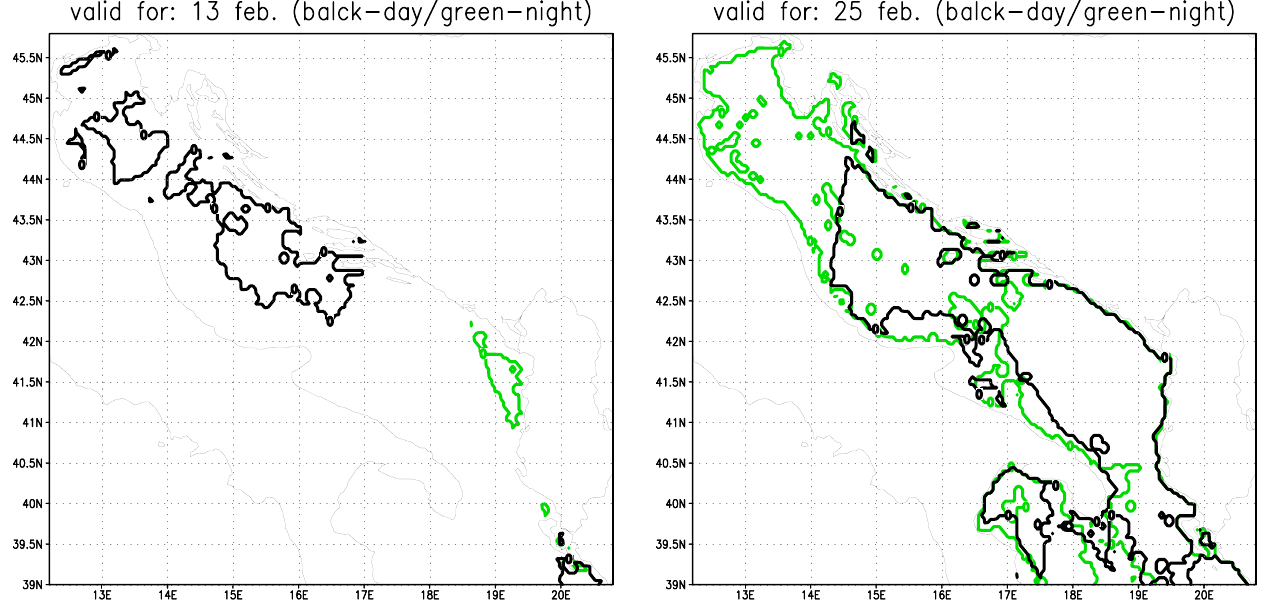
Fig. 9. The left panel shows an example of very small overlaps in satellite coverage from day to night. The data come from 13 February 2006. The green line denotes the night satellite pass, while the black line denotes the day satellite pass. Note that the two areas overlap only at the south entrance of the Adriatic and only very close to the Albanian coast. The right panel shows satellite coverage for 25 February. Note that in this case, the day and night coverage overlaps over an extensive portion of the Adriatic